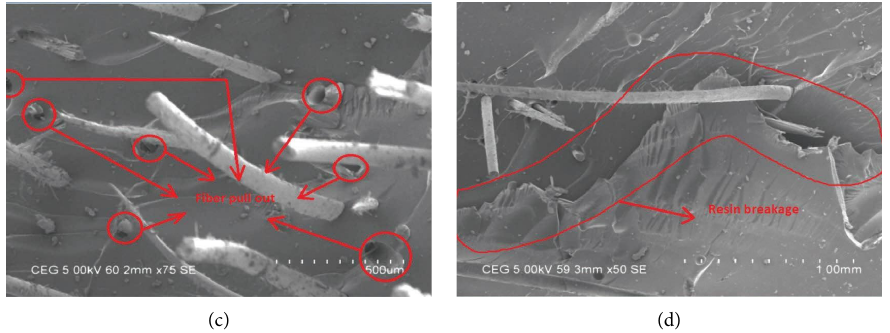
Figure 4: SEM image of (a) 60% epoxy and 40% fber after tensile fracture; (b) 90% epoxy and 10% fber-presence of void; (c) 90% epoxy and